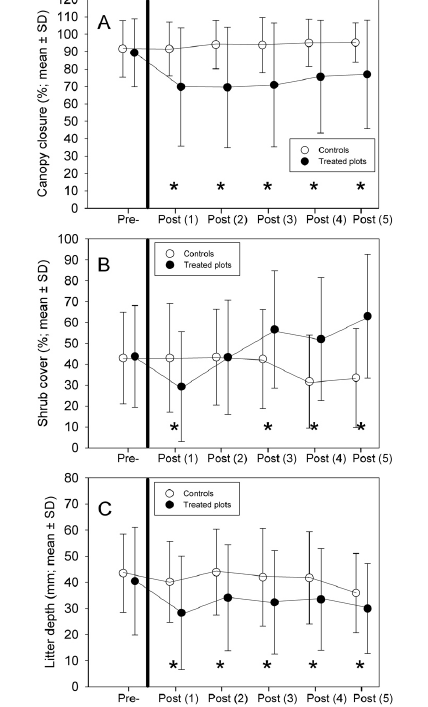
Fig. 2 . Mean (± SD) canopy cover (A), shrub cover (B), and litter depth (C) in treated plots (4 plots) and controls (2 plots) one year preharvest and the first five years postharvest. The solid line delineates the pre- from the postharvest years and asterisks (*) indicate significant year- specific treatment